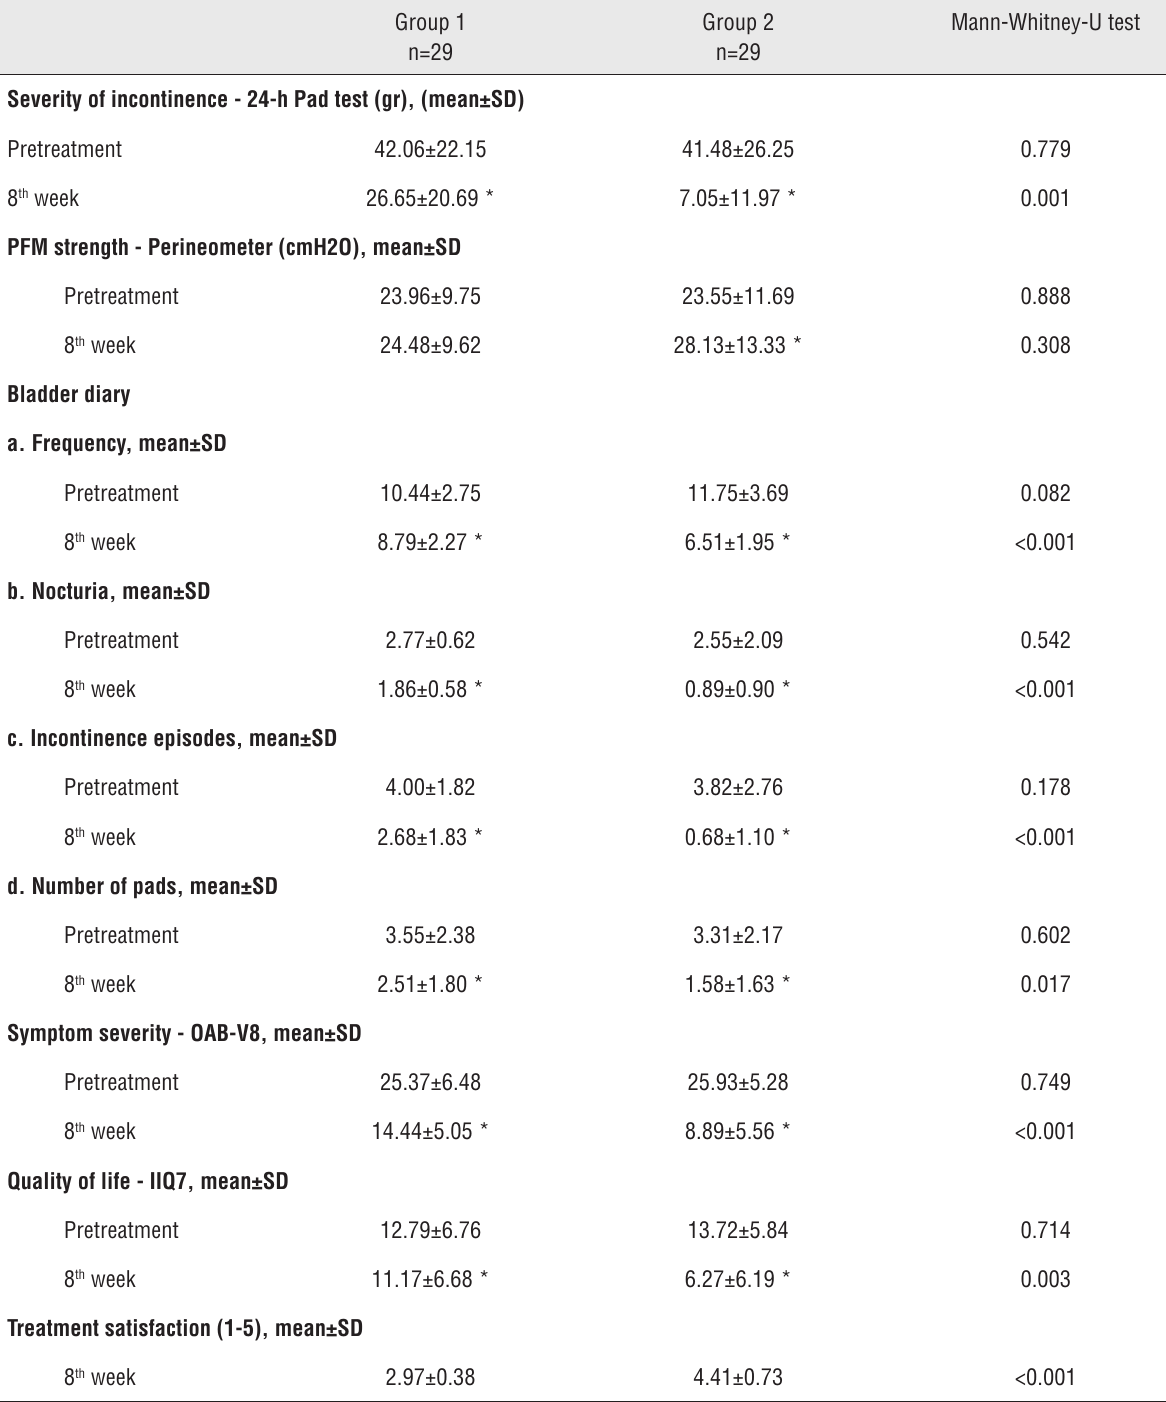
Table 2 - Comparison of treatment groups in assessment